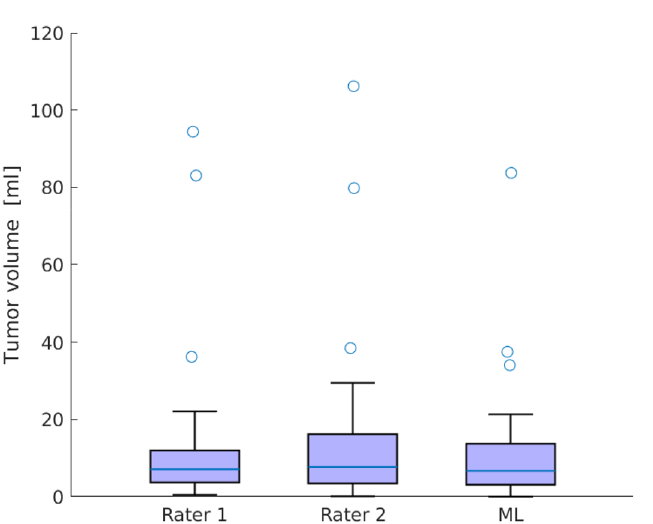
Figure 3. Tumor volumes of rater 1, rater 2, and machine learning. We found no difference in median tumor volume between the raters and the machine learning application (Friedman test, p = 0.28 ). For each box, the central mark shows the median, and the box extends to the 25th and 75th percentiles. The whiskers extend to the most extreme data not considered outliers, while outliers are plotted individually.